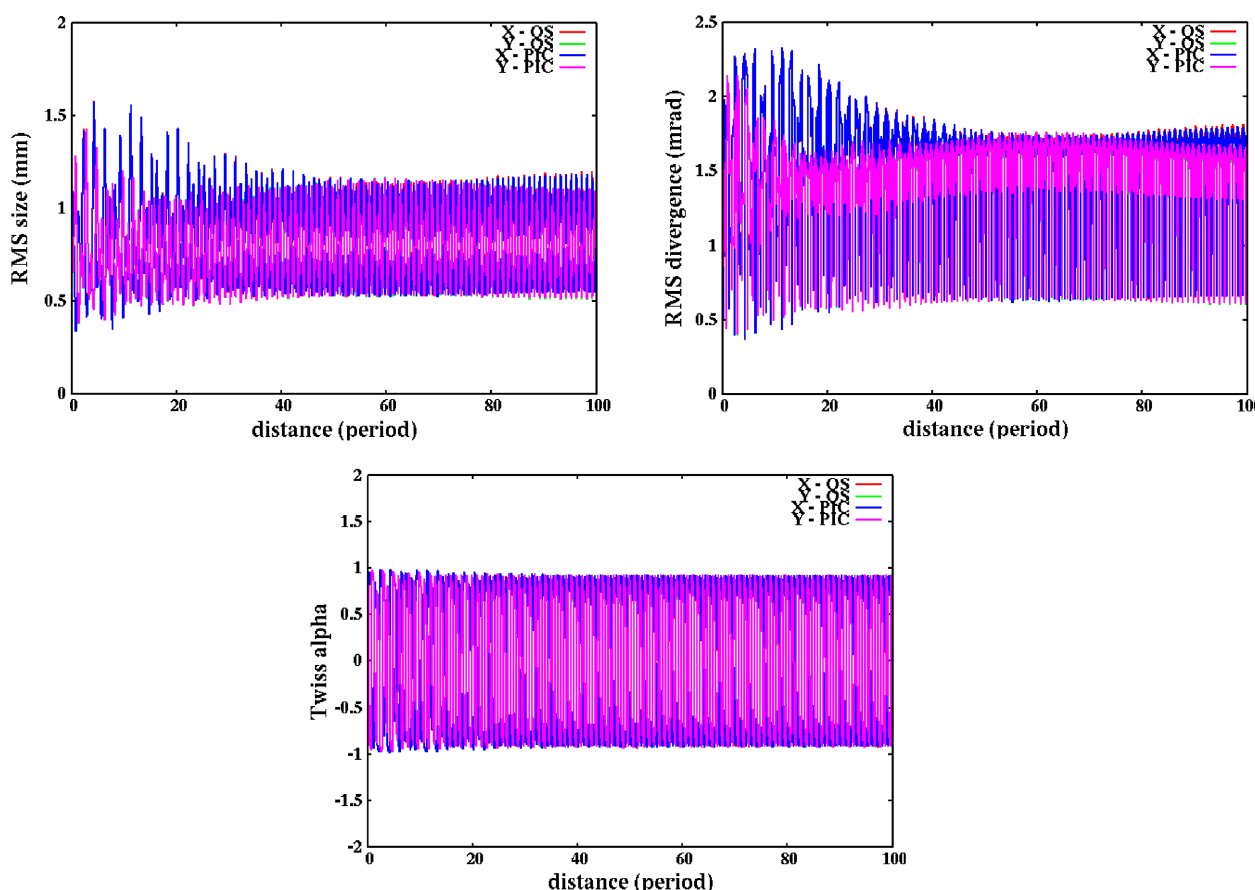
FIG. 6. Horizontal (x) and vertical (y) rms size (top left), rms momentum (top right), and beam Twiss alpha parameter (bottom) evolution through a five period FODO lattice from the quantum Schrödinger method (red and green) and from the PIC method (blue and magenta) with the mismatched space-charge effects.